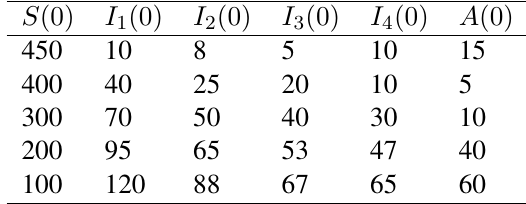
Table 2: Initial